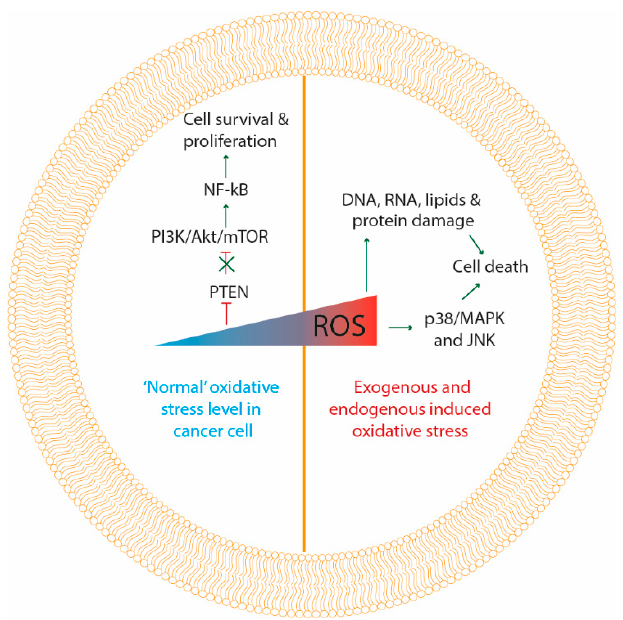
Figure 2. Molecular responses to oxidative stress. At moderate “normal” levels of oxidative stress in cancer cells (left side of the figure) ROS inactivate phosphatase and tensin homolog (PTEN) and unlock PI3K / Akt / mTOR pathway, which in turn activates NF-kB, consequently activating cancer cell survival and proliferation signaling. At high levels of oxidative stress induced by therapy, damage is produced to DNA, RNA, proteins, lipids and mitochondria, initiating apoptotic cell death. Additionally, high levels of ROS can activate p38 / MAPK and JNK apoptotic signaling proteins, inducing cancer cell death.